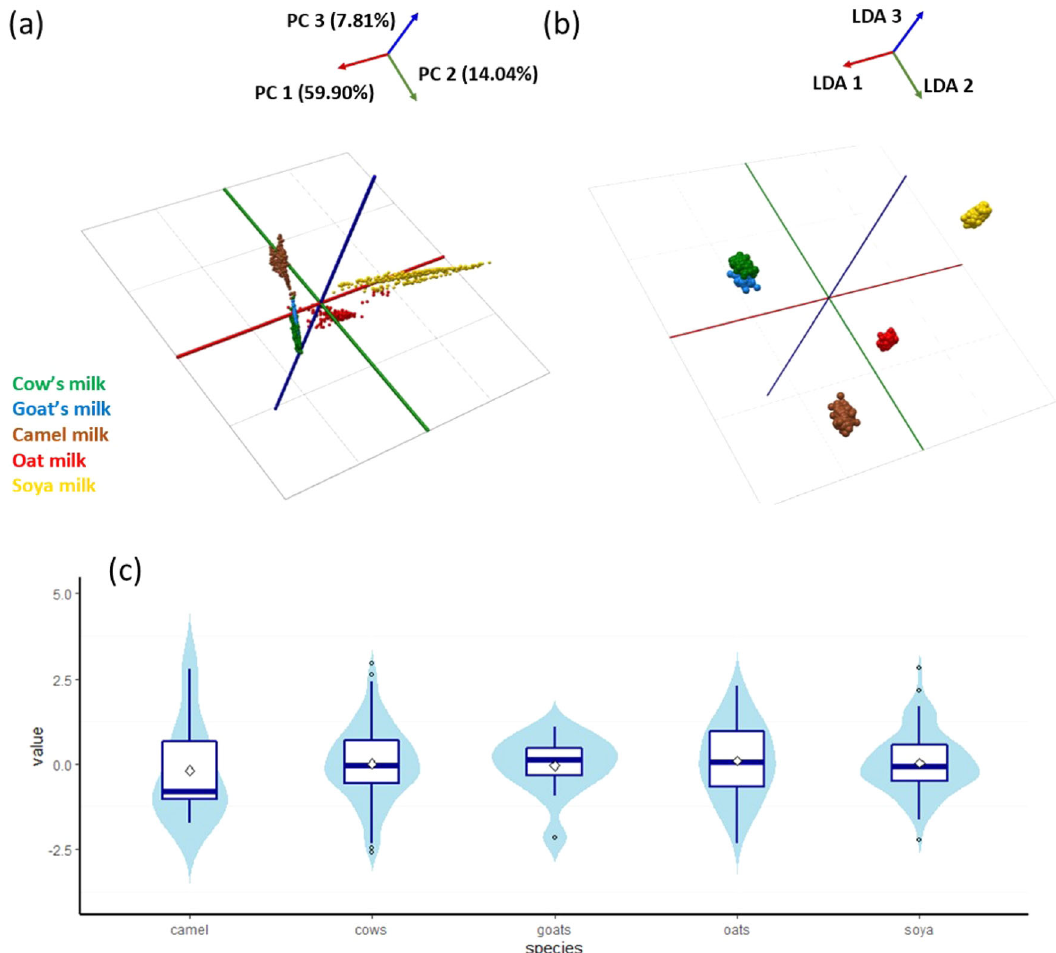
Fig. 2 Main effects of within-group differences on milk species identi fi cation. a PCA score plot and b LDA plot of DESI-MS spectral data (m/ z 100 – 20,00) obtained from fi ve milk species (different production procedure and farm location inside each group). c Violin and box plots for the distribution of validation scores. There was no statistical signi fi cance among the measurements of all the fi ve milk species ( p < 0.01). Symbols indicate outliers, which show the discrete degree of